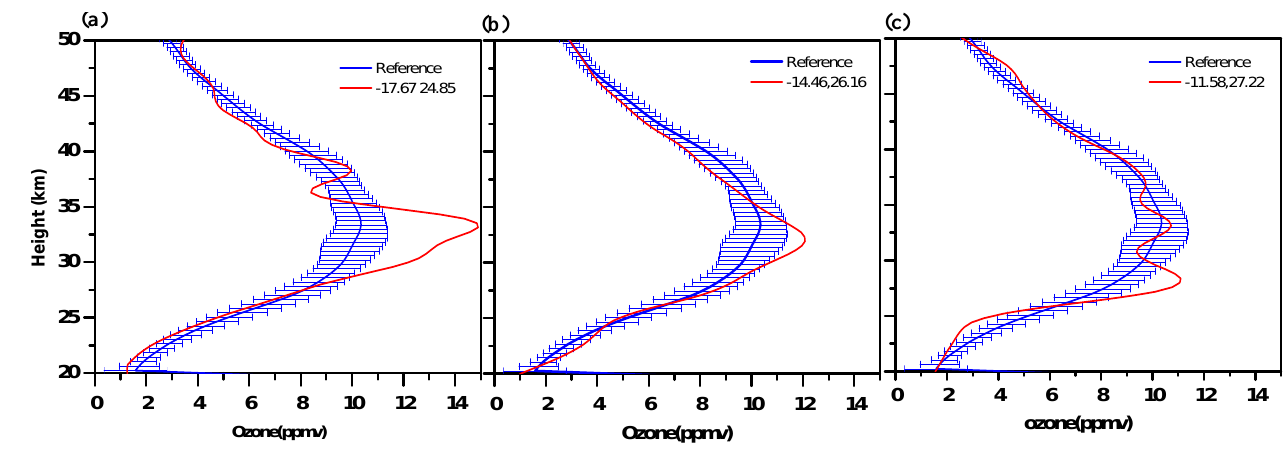
Fig. 3. Height profiles of ozone measured after ∼ 3h of the maximum obscuration of the Sun over African region. Geographical locations are provided in the